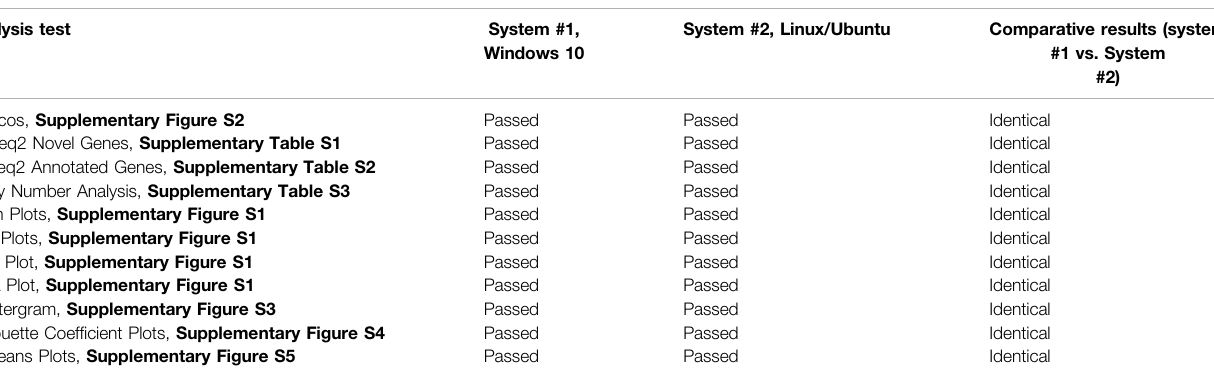
TABLE 1 | NPARS Accuracy and Reproducibility Testing Summary. Analysis